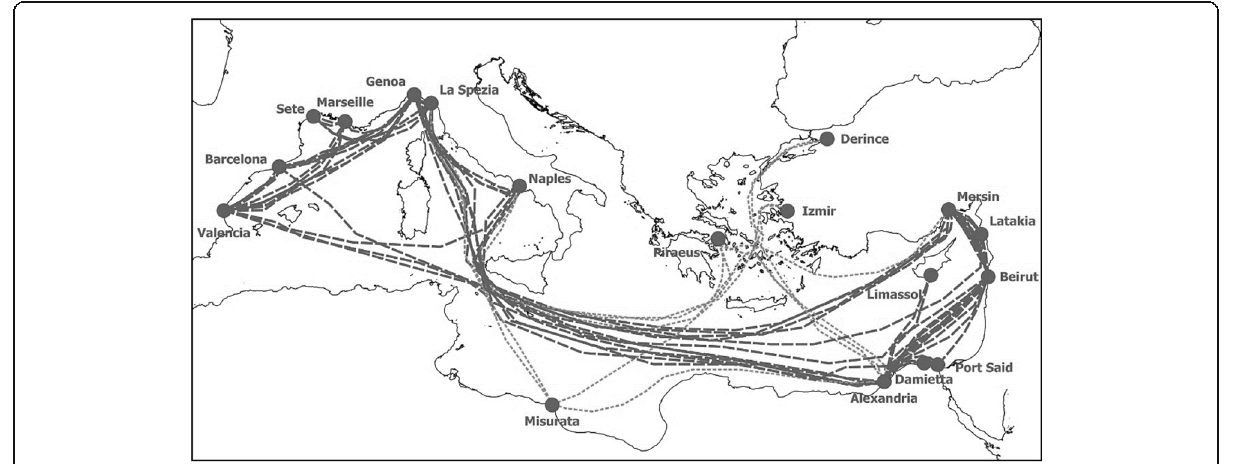
Fig. 1 Map of existing liner ro-ro